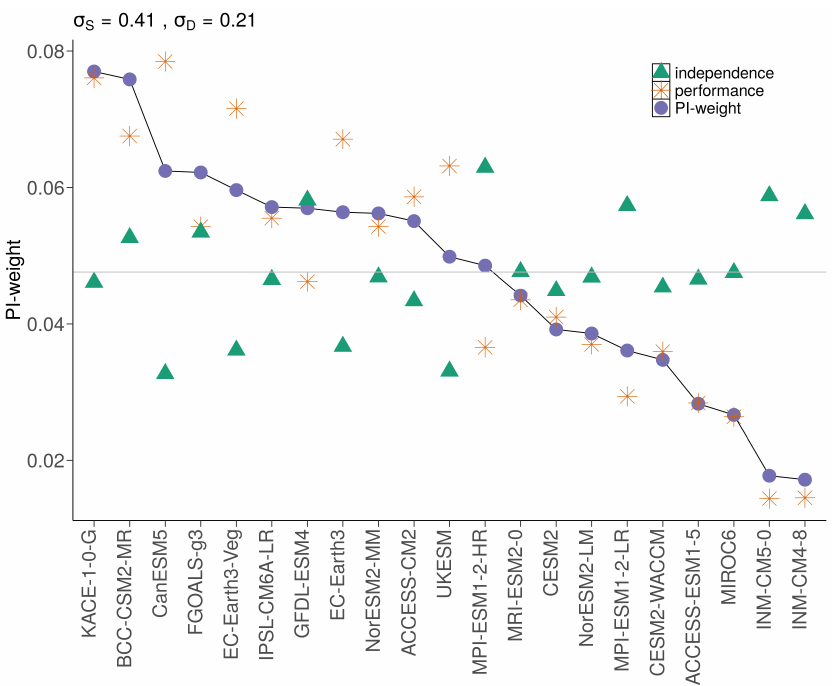
Figure 5. Spread of the weights for the 21 CMIP6 models obtained based on the performance only, the independence only, and both the performance and independence. The weights are obtained from the five climate variables for East